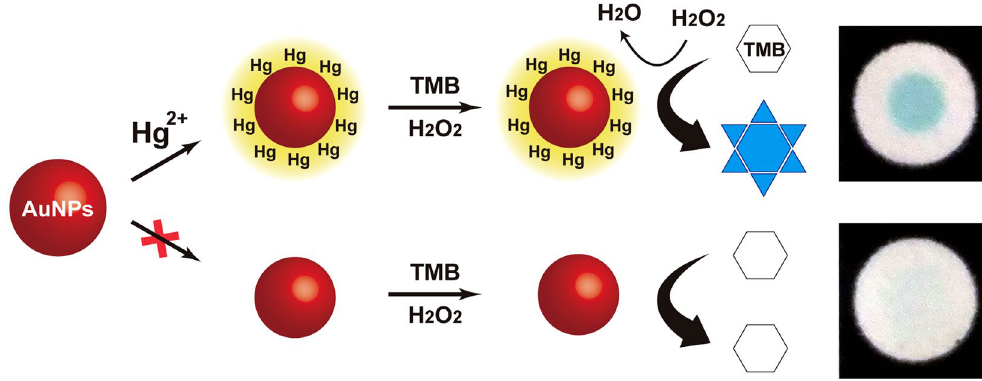
Figure 1. Schematic illustration of the AuNZ-PAD colorimetric sensing mechanism for Hg 2 + ions based on the mercury-promoted nanozyme activity of AuNPs. When Hg 2 + ions are introduced onto the AuNZ-PAD, the TMB–H 2 O 2 catalytic reaction is highly enhanced by the formation of Au–Hg amalgam, resulting in blue staining of the paper